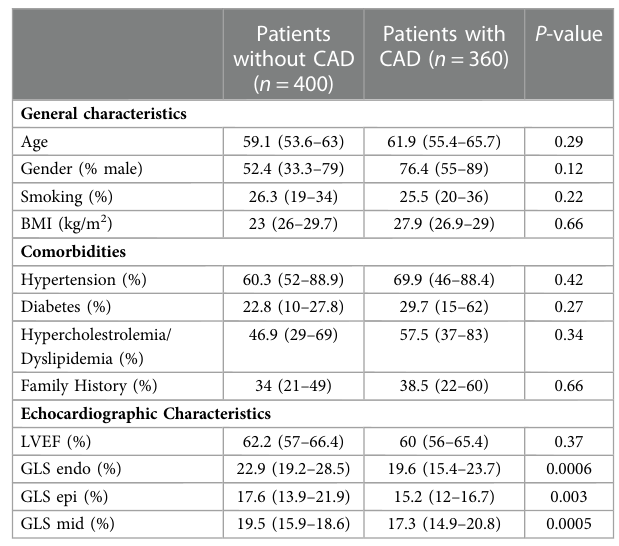
TABLE 3 Baseline characteristics of patients included in the diagnostic studies (group